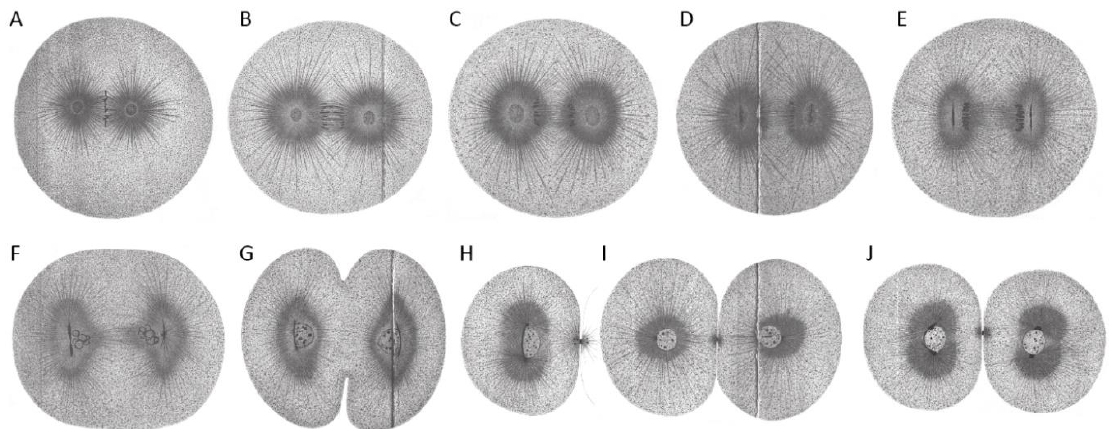
Figure 3. First cleavage in the early embryo of Echinus microtuberculatus . Sea urchin embryos were fixed in picric-acetic acid and stained with iron haematoxylin. ( A ) Chromosomes are arranged at the metaphase plate (equatorial plane). Centrosomes are spherical. ( B ) Centrosomes increase in size while homologs become separated. ( C ) Centrosomes start to flatten in the direction parallel to the division axis. ( D ) Flattened centrosomes change to discoidal form. ( E ) Centrosomes adopt a discoidal shape. ( F ) Spindle and egg elongate. Chromosomes are visible and centrosomes start to divide. ( G ) Cytokinesis of the embryo starts. ( H , I ) Embryonic daughter cells are formed (side-view ( H ) and cross-section/top-view ( I ) according to division axis). ( J ) Each daughter cell contains a nucleus and two centrosomes. Reproduced from [2].